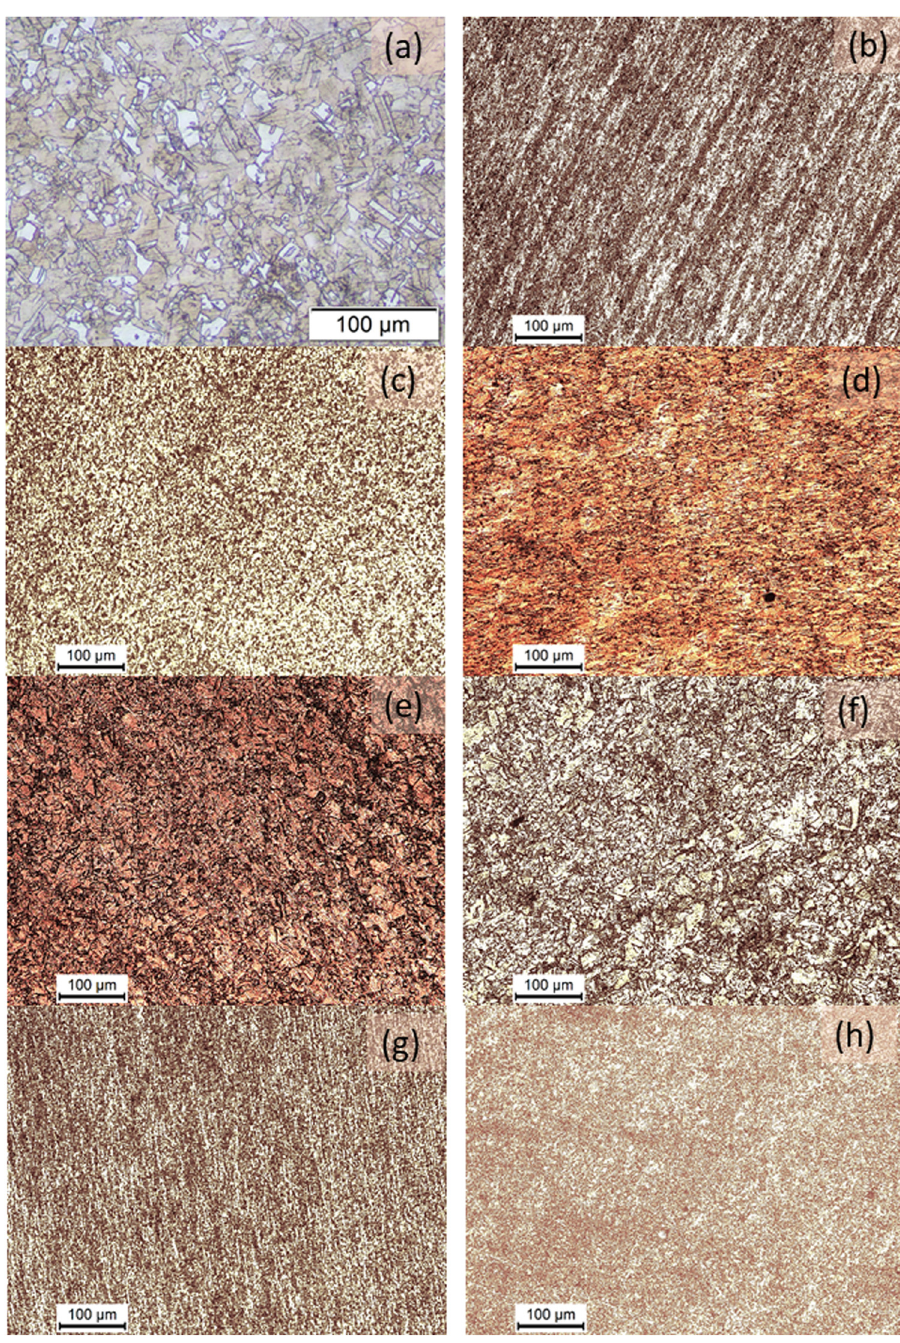
Figure 8: OM micrographs of the AA ( a ) , Cu billets and ECAPed billets processed through 2 - Bc _90° - die ( b ) , 6 - Bc_90° - die ( c ) , 6 - A_90° - die ( d ) , 6 - C_90° - die ( e ) , 6 - Bc_90° - die ( f ) , 2 - Bc_120° - die ( g ) , and 6 - Bc_120° - die ( h ) at RT ( b , c , d , e , g , and h ) and at 200°C ( f )